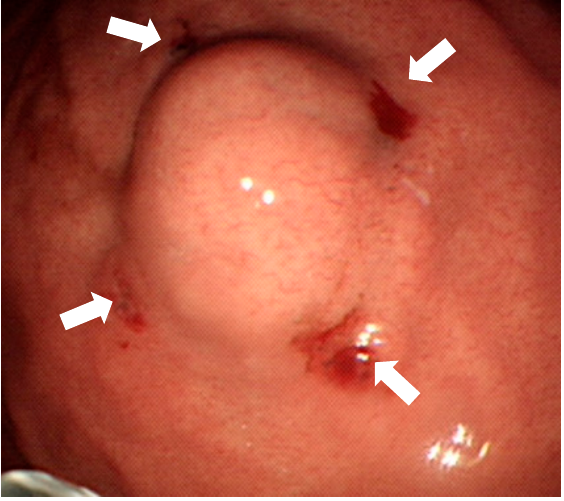
Figure 1. Endoscopic tattooing with SPOT before laparoscopic resection of the subepithelial tumor. The “four quadrants” method is used so that 0.1 mL SPOT is injected into muscularis propria layer by perpendicular injection (white arrows). Only puncture holes are left and there is no submucosal injection.